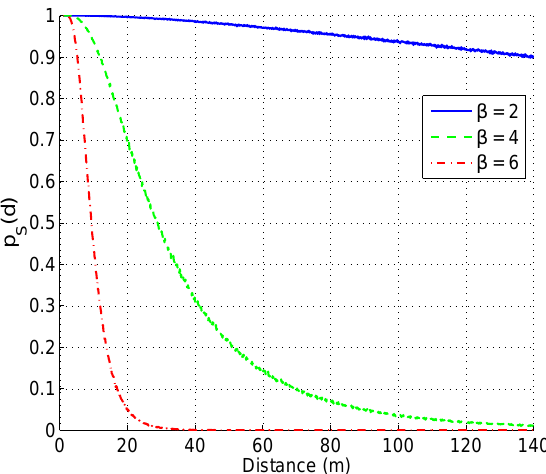
Figure 3. Illustration of the relationship between distance and p S ( d ) between two nodes with β = 2, β = 4, and β =